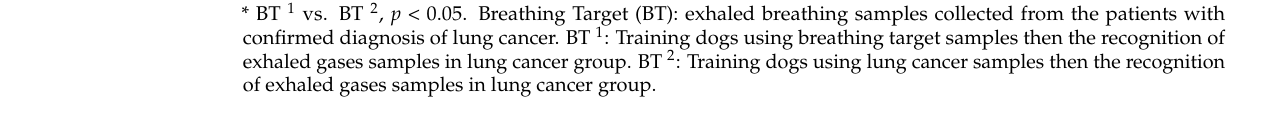
Table 5. The relationship between the diagnostic rates of lung cancer by sniffer dog using BT and lung cancer stage or tumor